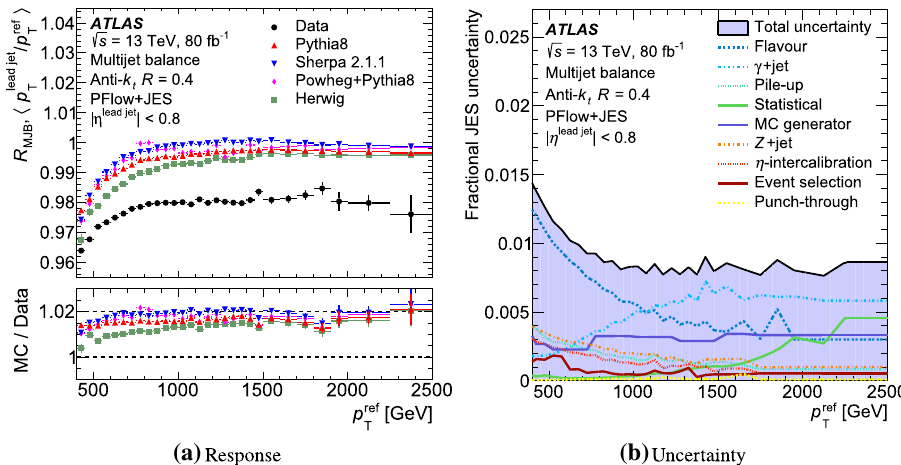
Fig. 16 a Response for the leading PFlow jet in multijet events as a defined by the comparison with Sherpa ; its difference from the Pythia result defines the ‘MC generator’ uncertainty in b . This uncertainty is function of p ref and b the systematic uncertainties on the response. T defined in a single-sided way by the measured response difference and Subleading jets in the event are calibrated using the Z /γ +jet MPF cor- therefore it is not symmetrised for display in b but instead its full one- rections, while the leading jet is calibrated only up to the η intercali- sided value is shown. Other uncertainties come from the event selection bration. The response is shown for data and for simulation using four and MC simulation/data statistics or are propagated from the Z +jet, different MC generators, and the MC simulation-to-data response ratios γ +jet, flavour, pile-up, η intercalibration, and punch-through in the bottom panel correspond to the derived in situ calibration. The error bars show the statistical uncertainties. The nominal calibration is